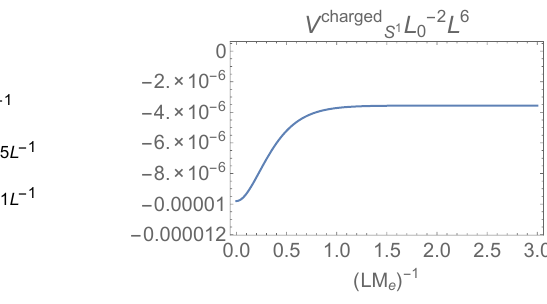
Figure 2 . Left: the potential of the U(1) gauge theory with a charged Dirac fermion, eq. (3.15) , is plotted as a function of the Wilson line. The potential takes minimum at q e + (1 (cid:0) z e ) = 2 = 1 = 2. Here we take (cid:3) 4 = 0. For the illustration, the vertical axis is not the potential itself, but the potential multiplied by L (cid:0) 2 L 6 . Right: the potential as a function of L , the radius of S 1 . The value 0 of the Wilson line is set to be at the minimum of the potential.